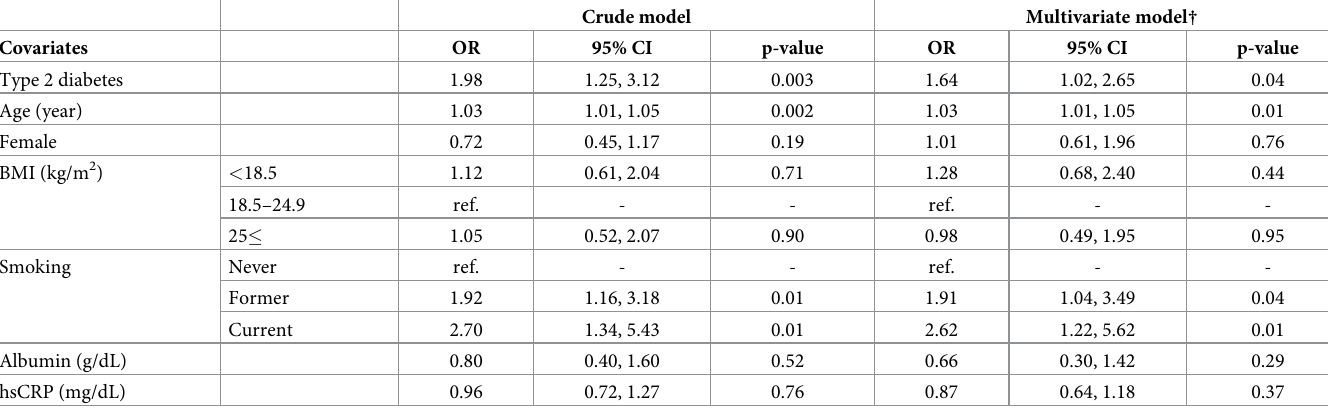
OR, Odds ratio; CI, Confidence interval; ref, Reference; BMI, Body mass index; hsCRP, High sensitivity c-reactive protein. † Adjusted for all